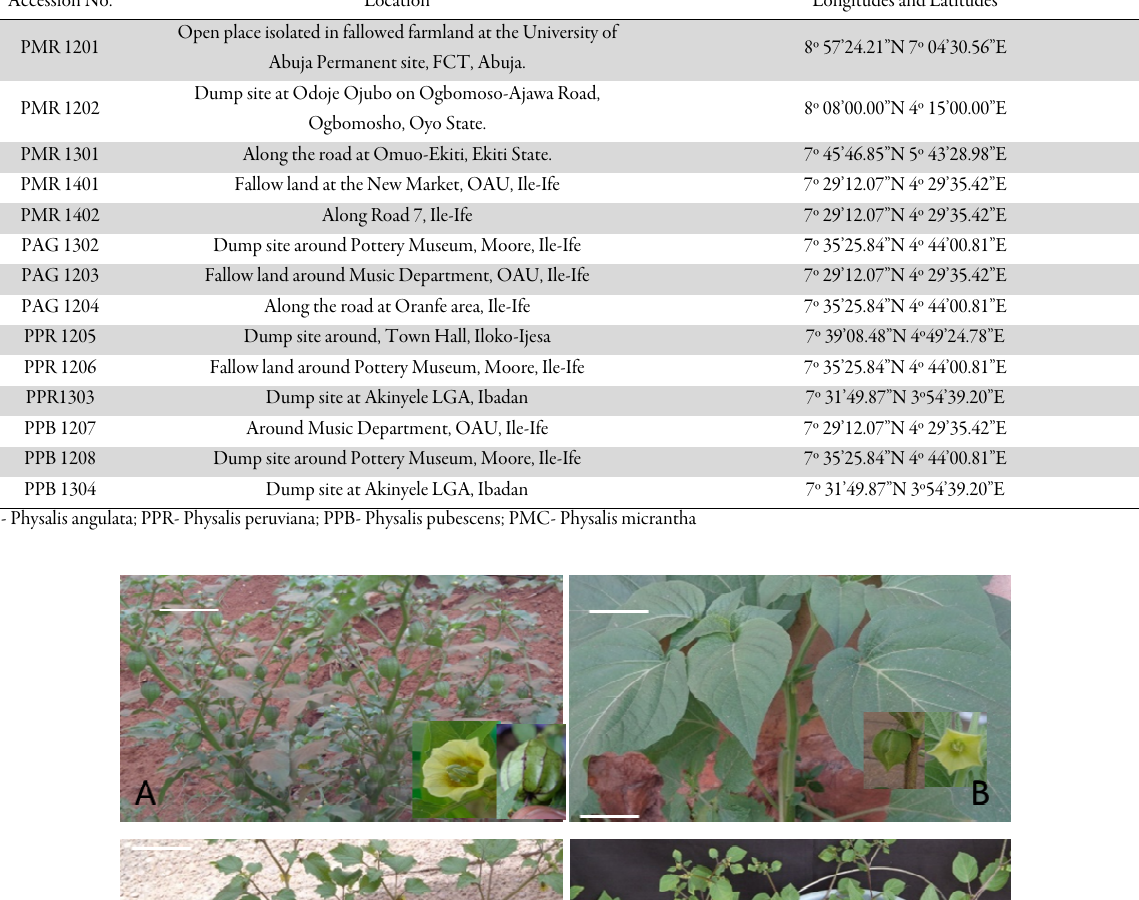
Table 1. Germplasm sources used for the study Accession No.